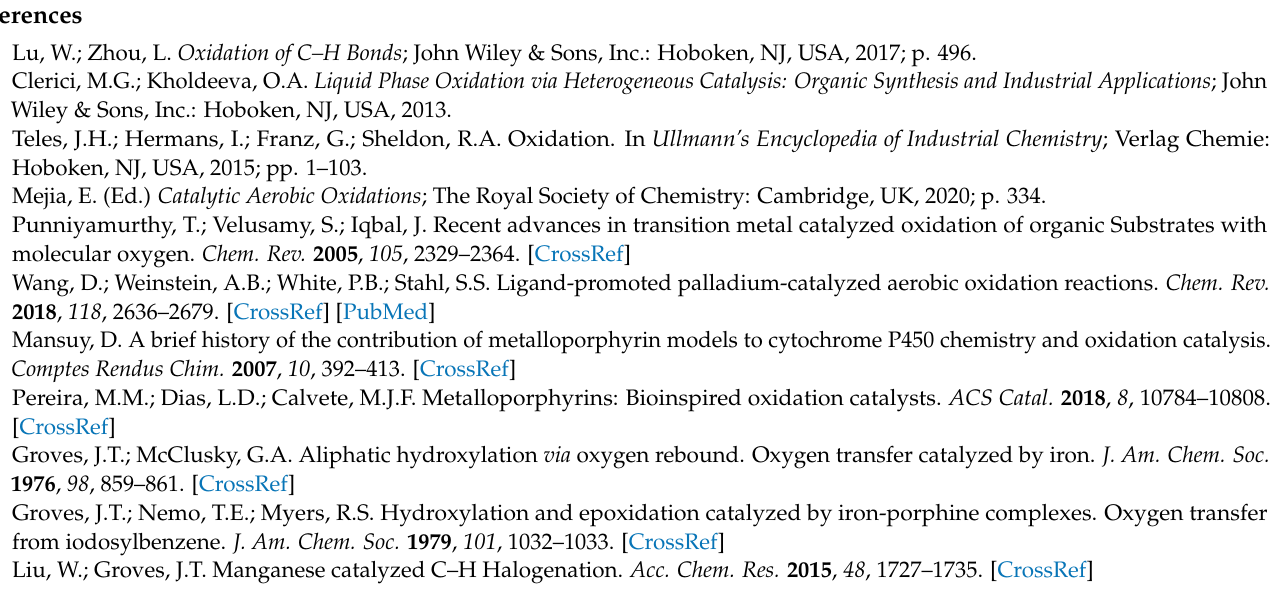
Figure S3: HRMS-ESI mass spectrum of Mn(TMPIP) ; Figure S4: HRMS-ESI mass spectrum of Mn(TMPIP-OH) ; Figure S5: EDX spectra in STEM mode of hybrid material Mn(TMPIP)/TiO 2 : all studied region (a), the region of 0–0.6 keV (b) the region of 0.6–1.4 keV (c), the results of quanti- tative analysis (d). Cu is observed because of spurious X-rays coming from the TEM copper grid; Figure S6: FTIR spectra of Mn(TMPIP) , Mn(TMPIP-OH) , Mn(TMPIP)/TiO 2 -1 and hydrated TiO 2 ; Figure S7: FTIR spectra of Mn(TMPIC) , Mn(TMPIC)/TiO 2 -1 , Mn(TMPIC)/TiO 2 , and hydrated TiO 2 ; Figure S8: SEM microphotographs of (a) bare hydrated TiO 2 , and (b) Mn(TMPIP)/TiO 2 ; Figure S9: The hot filtration test for oxidation reaction of thioanisole with molecular oxygen in the presence of Mn(TMPIP)/TiO 2 and IBA (Table 2, entry 1); Figure S10: Kubelka-Munk transformed